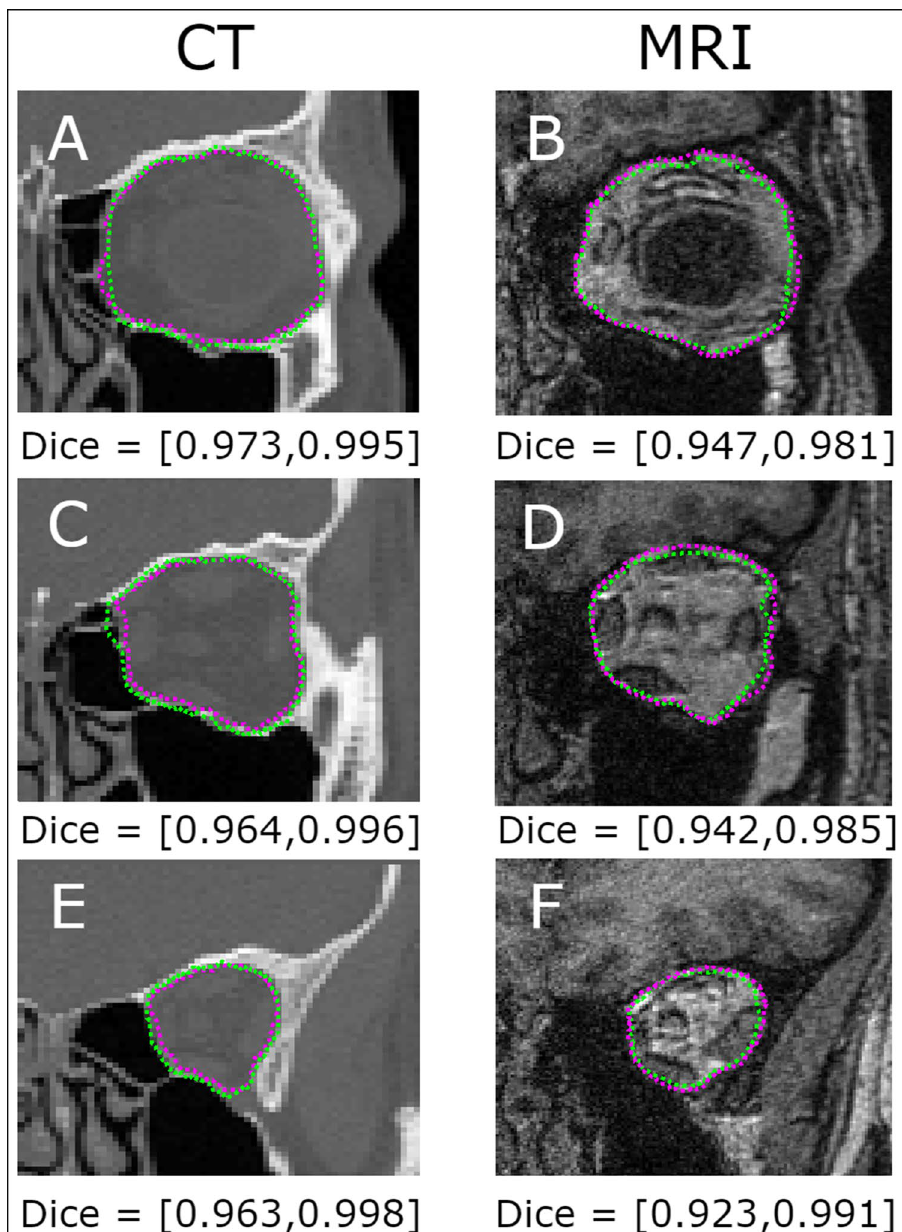
represent approximately the same cross-section. The subplots show different cross-sections (depths) from the same orbital volume. Green dotted line represents the proposed automatic method and the dotted magenta is the ground truth. The dice include the orbit (left) and background (right)